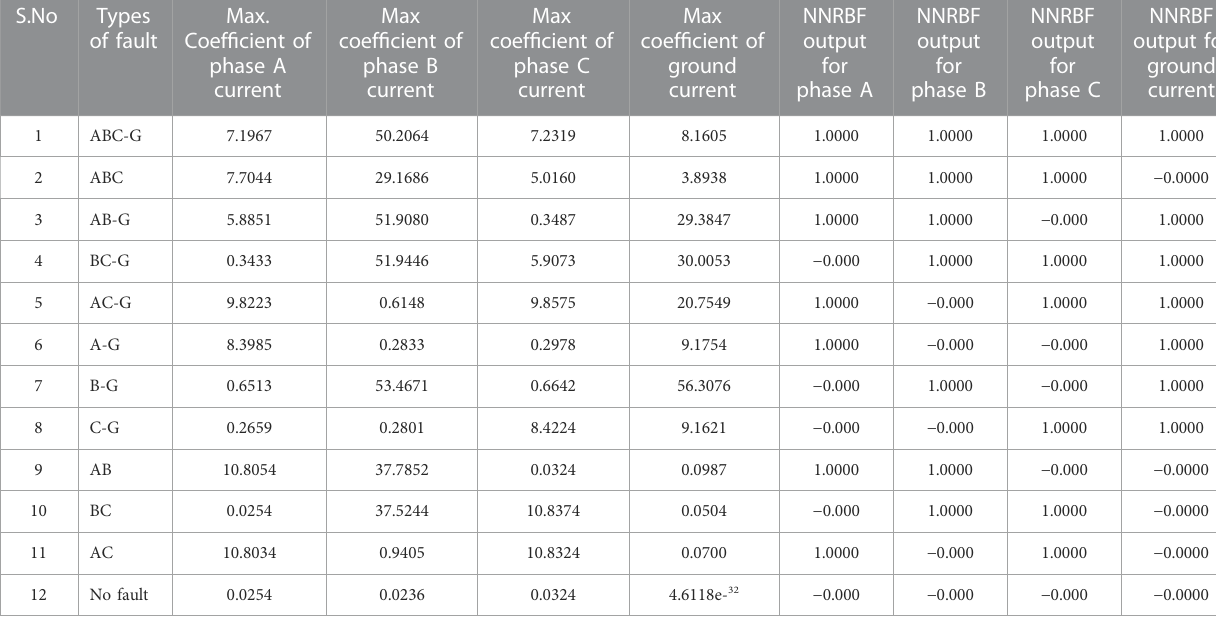
TABLE 2 Ground resistance 10 Ω location at 5th